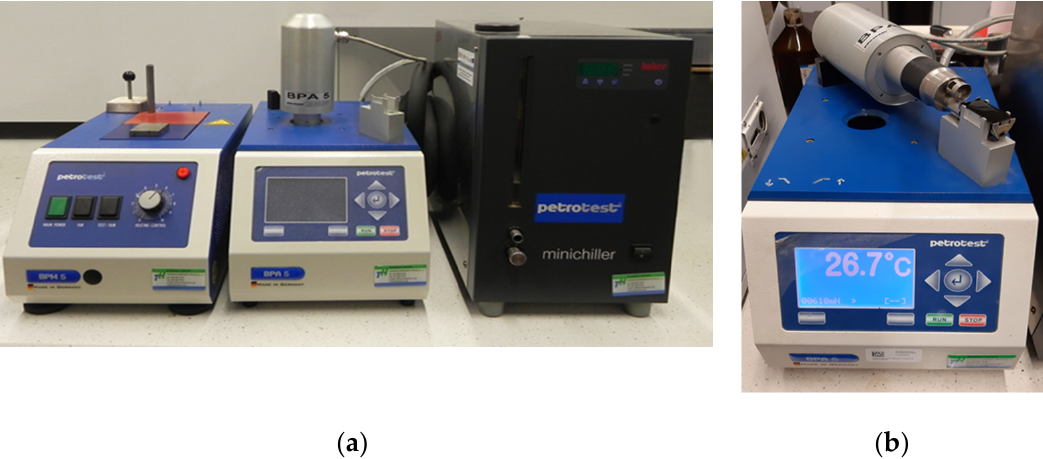
Figure 9. Automatic measuring device for Fraass breaking point determination ( a ), bitumen specimen ( b ) (photo by M. M. Iwa ń ski).